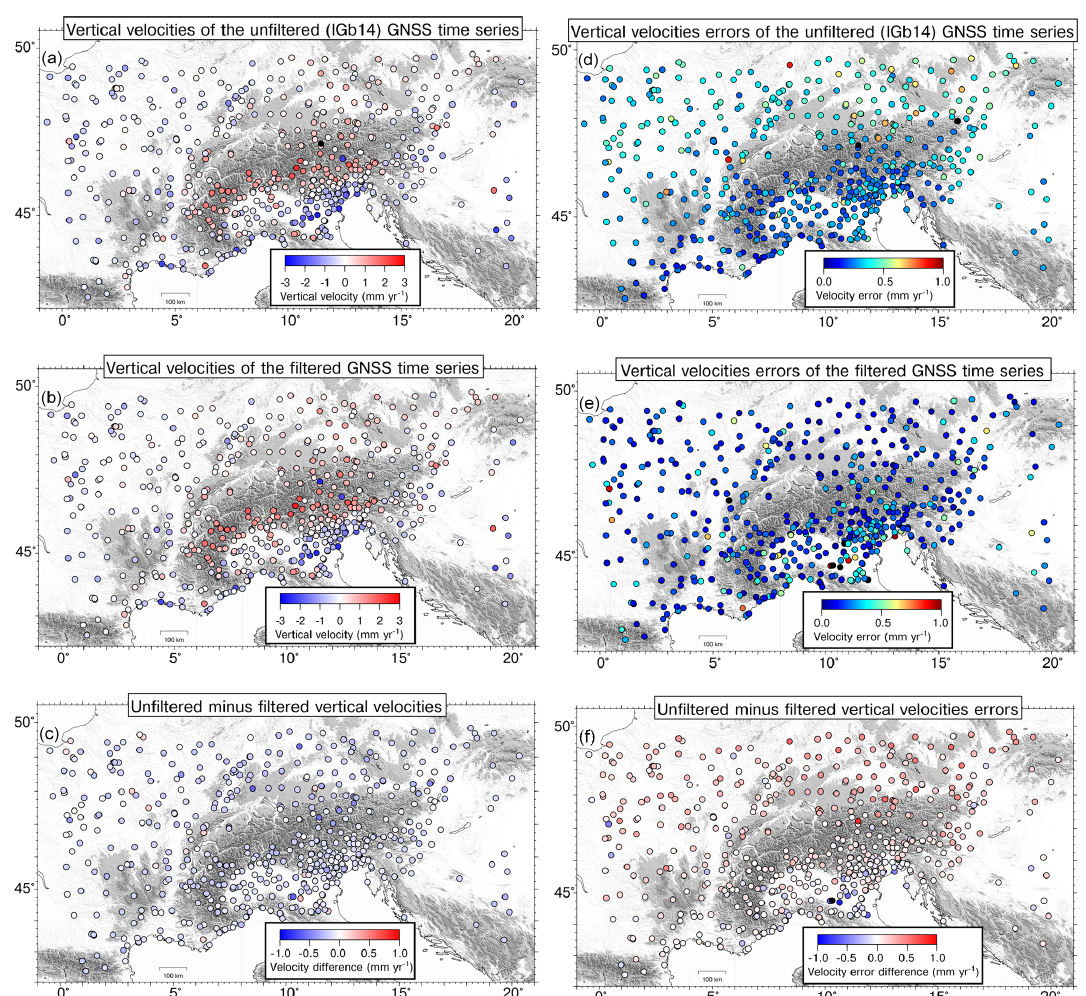
Figure 10. (a) Vertical velocities from the unfiltered GNSS time series. (b) Vertical velocities from IC-filtered time series, obtained after subtracting the displacements associated with the first four ICs. (c) Difference between the velocities of (a) minus velocities of (b) . Panels (d) , (e) (f) are the same as (a) , (b) and (c) , respectively, but showing the error associated with the vertical